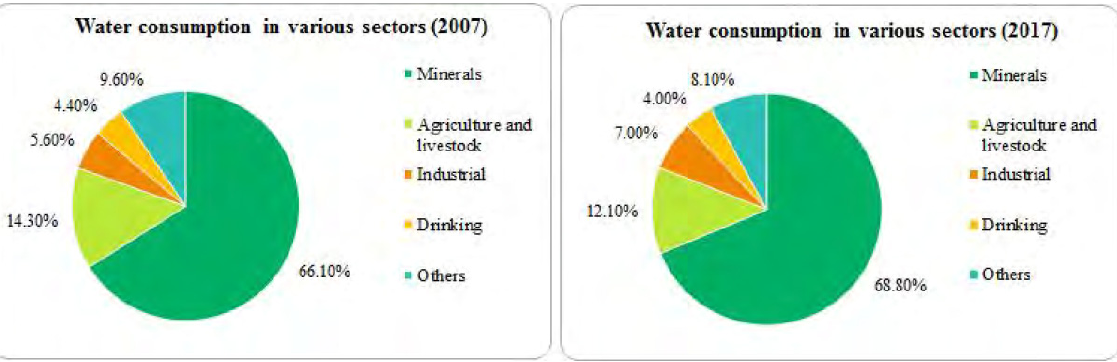
Figure 1. Water consumption in Antofagasta Region (Region II) of Chile [4].